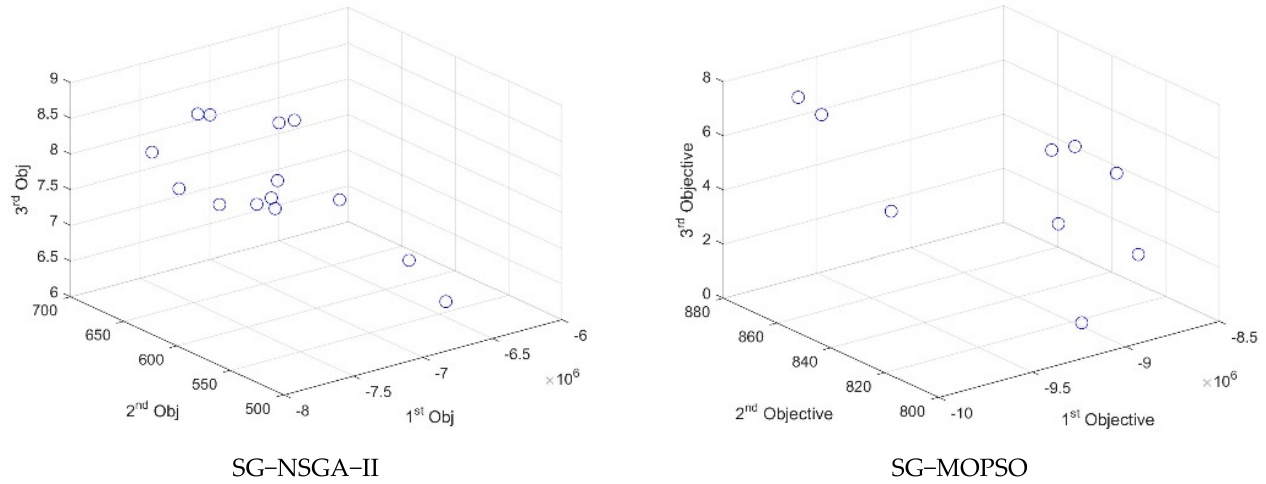
Figure 4. The space distribution of obtained Pareto optimal solutions. Table 4. Indicators and efficiency values calculated by SG − NSGA − II.